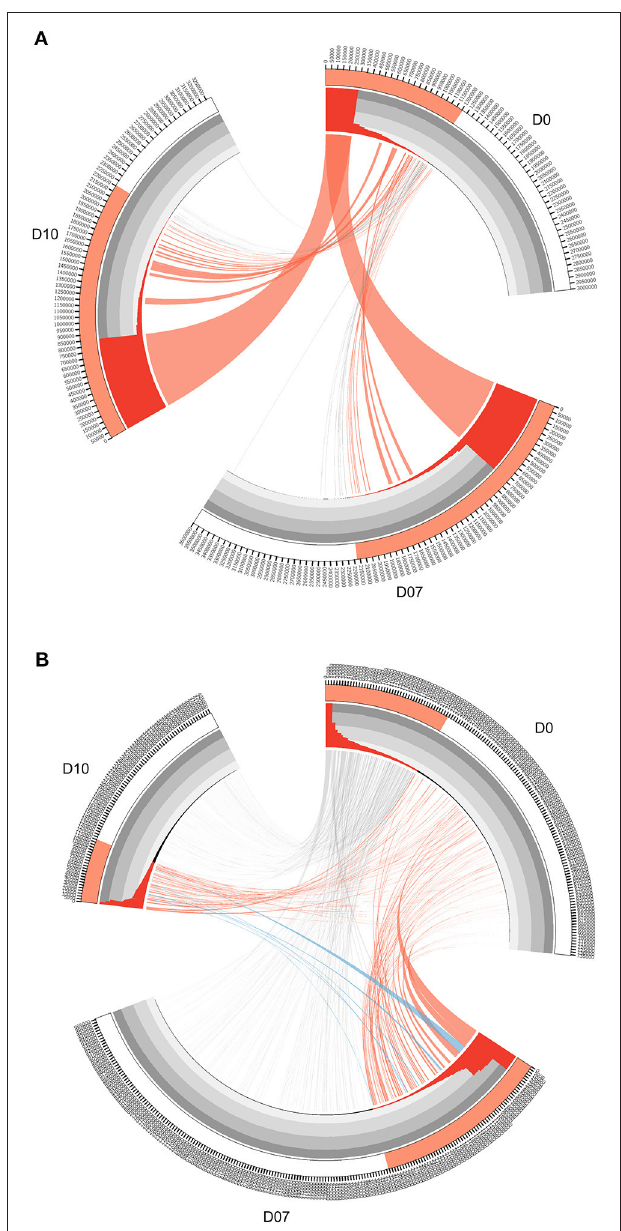
FIGURE 3 | Circos diagrams of pattern change of TRB clone frequency and IGH lineage frequency during the time course of final boost of rhesus macaques A5R069 from the N51 group. (A) Clones were sorted by their frequency at three different time points, the clone number of each time point is ticked on the outer lane. High abundance clones ( > 0.01%) are marked in red. The inner histogram lane shows the frequency of each clone with the height of each bar representing the relative abundance. The width of both the histogram and ribbon represents the frequency of each clone. Ribbons connect the same TCR clones at different time points. The ribbons connecting the high abundance clones at D7 and D10 that showed increase in frequency of more than 1-fold compared to D0 were labeled in red, those connecting the clones showing 50% decrease in frequency were labeled in gray, and those connecting the newly emerged clones that have high abundance ( > 0.01%) were labeled in blue (B) . IGH lineages were plotted similarly as in (A) , with the exception that red ribbons connecting high abundance lineages ( > 0.05%) at D7 and D10 that showed increase in frequency by more than 3-fold compared to